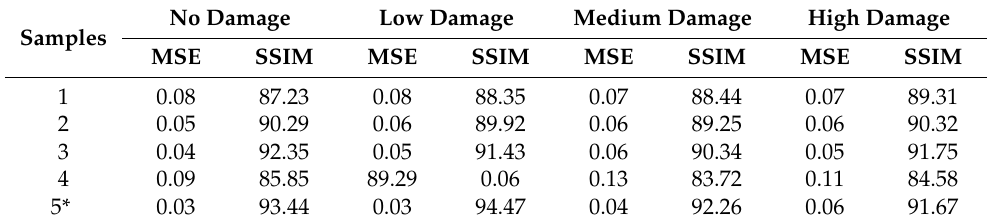
Table 23. Final reconstruction of images from each class with a slight difference of results.